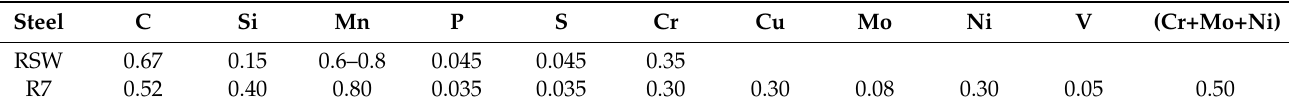
Table 2. Chemical composition of wheel steel (wt.%).